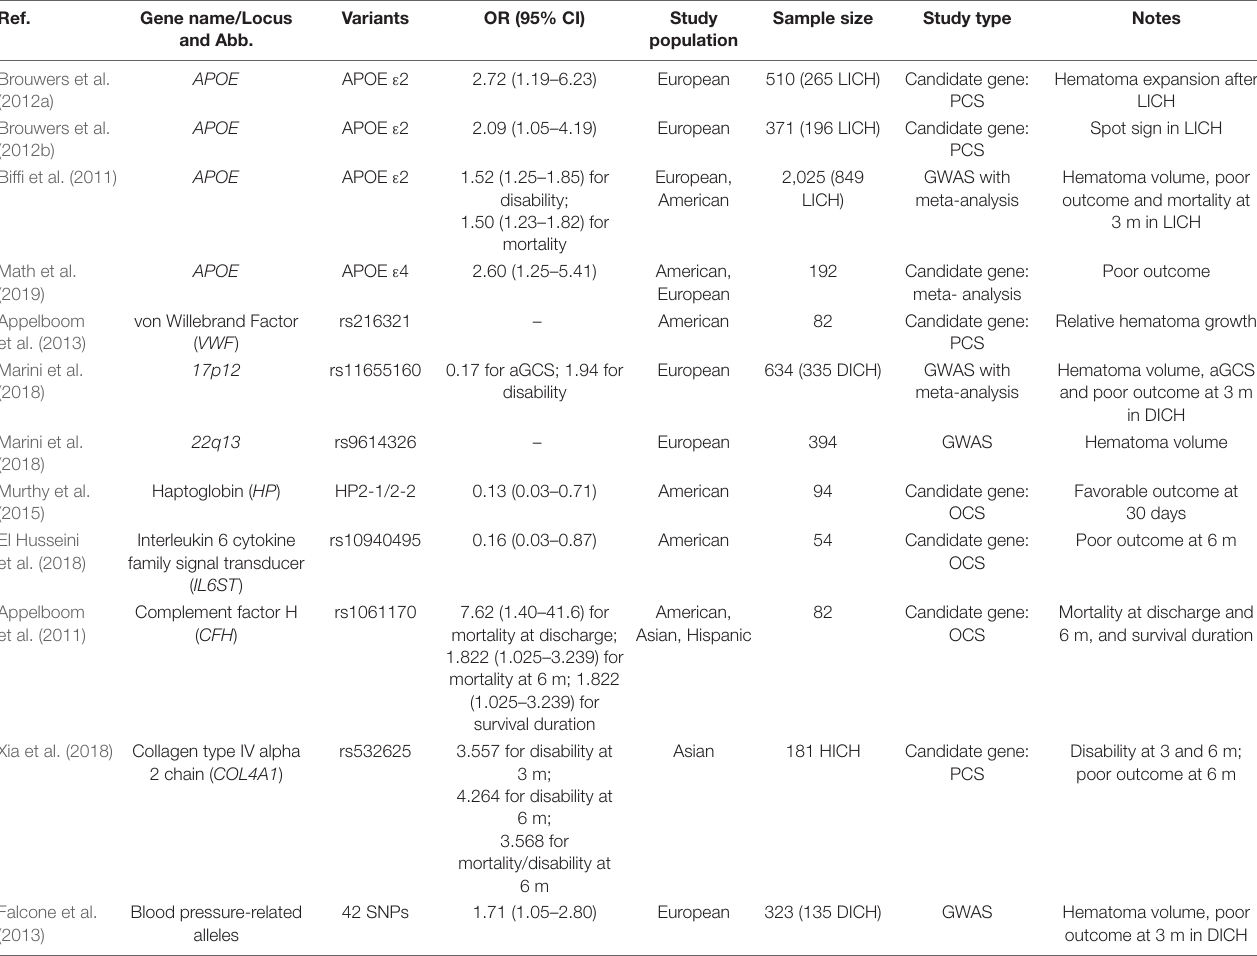
TABLE 4 | Genetic variants related to ICH hematoma and outcome.